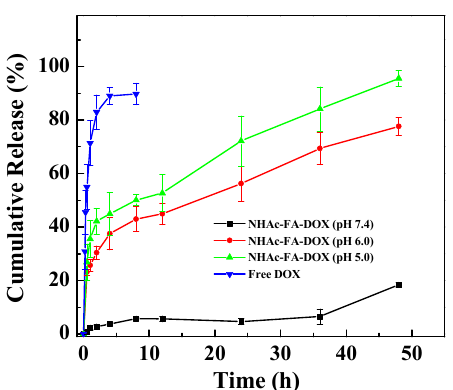
Figure 3. In vitro release profiles of DOX from G5.NHAc-FA-DOX conjugates in citrate buffer solutions (pH 7.4, pH 6.0, and pH 5.0) and the release of free DOX·HCl in citrate buffer solution (pH 7.4) at 37 °C.